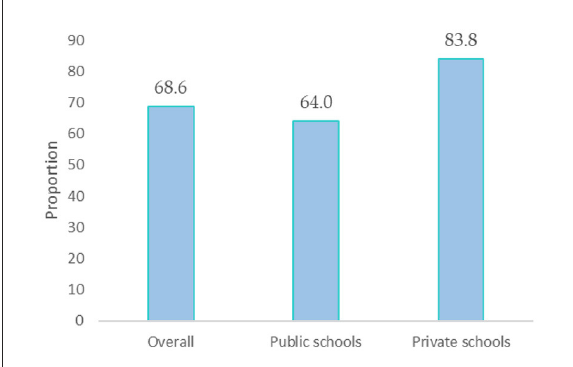
FIGURE1 The proportion of adolescents not receiving nutrition education in school’s